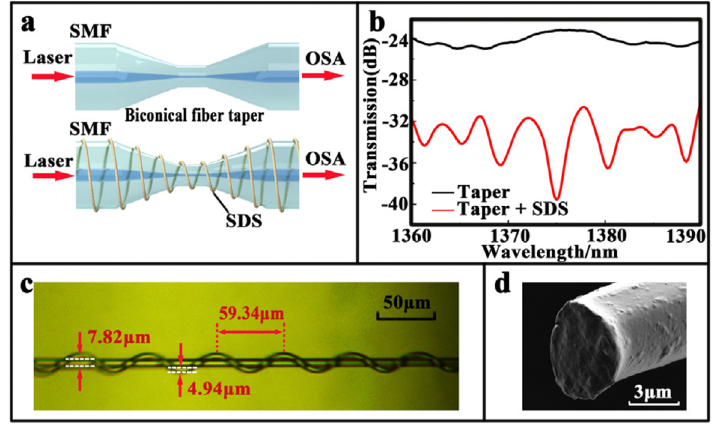
Figure 35. Point sensor. ( a ) Illustration of the biconical optical fiber taper and the spider-silk wrapped around the tapered fiber. ( b ) Interference spectra of the two versions. ( c ) Image of silked-coiled tapered fiber. ( d ) Scanning electron micrograph of spider dragline silk. Reprinted with permission from ref. [186]. Copyright 2020 Elsevier